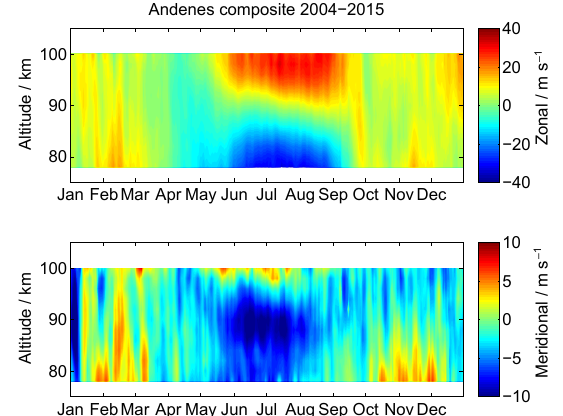
Figure 1. Composite of the zonal and meridional winds above the Andenes MR. The composite is computed averaging all measure- ments between 2003 and